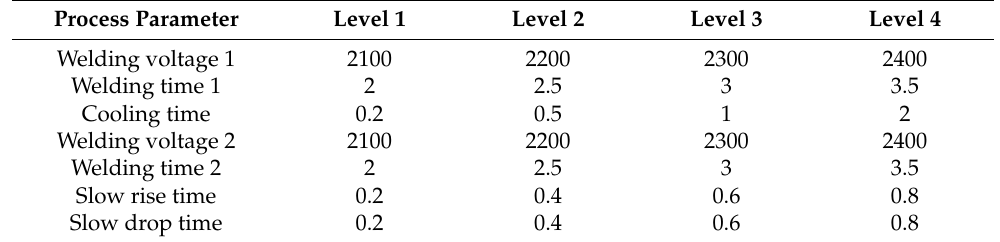
Table 2. Copper-nickel single-sided double-joint welding orthogonal experimental factor level